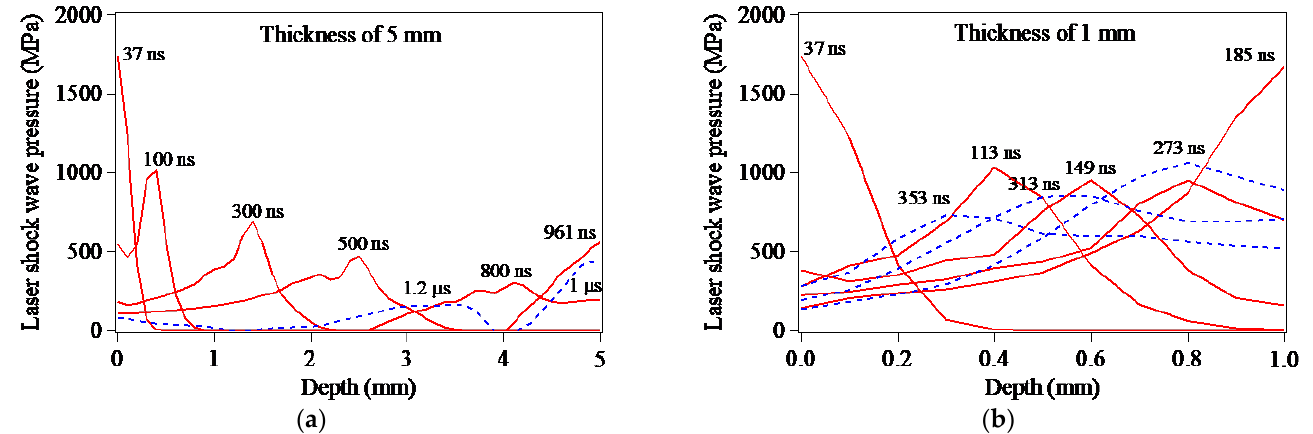
Figure 9. LSP − induced shock waves propagating along Path − Z in the target models: ( a ) 5 Figure 9. LSP-induced shock waves propagating along Path-Z in the target models: ( a ) 5 mm- mm − thickness target model; ( b ) 1mm − thickness target model. thickness target model; ( b ) 1 mm-thickness target